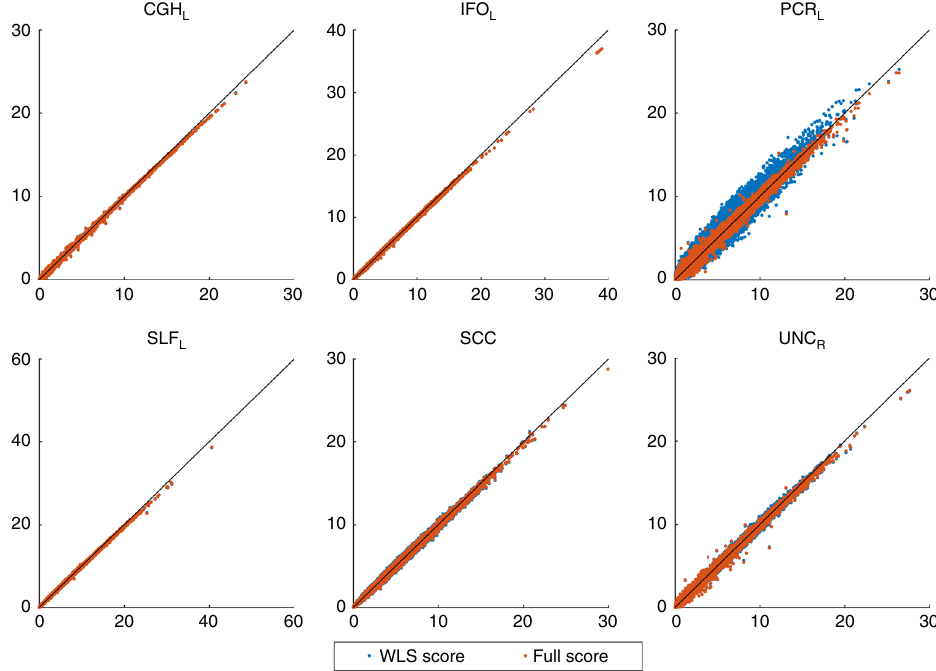
Fig. 6 Comparison of test statistic values for association testing (H 0 : β 1 = 0) using real data analysis. Results shown for the non-iterative and fully converged random effect estimators based on the simpli fi ed REML function and FaST-LMM ’ s LRT. Each plot represents a ROI where x -axis shows FaST- LMM ’ s LRT and y -axis represents the score test. Despite strong concordance between the score test results using WLS or fully converged random effect estimator, FaST-LMM is slightly more powerful, consistently for whole brain parcellation (see Supplementary Figures 10 and 11 for the rest of the ROIs)